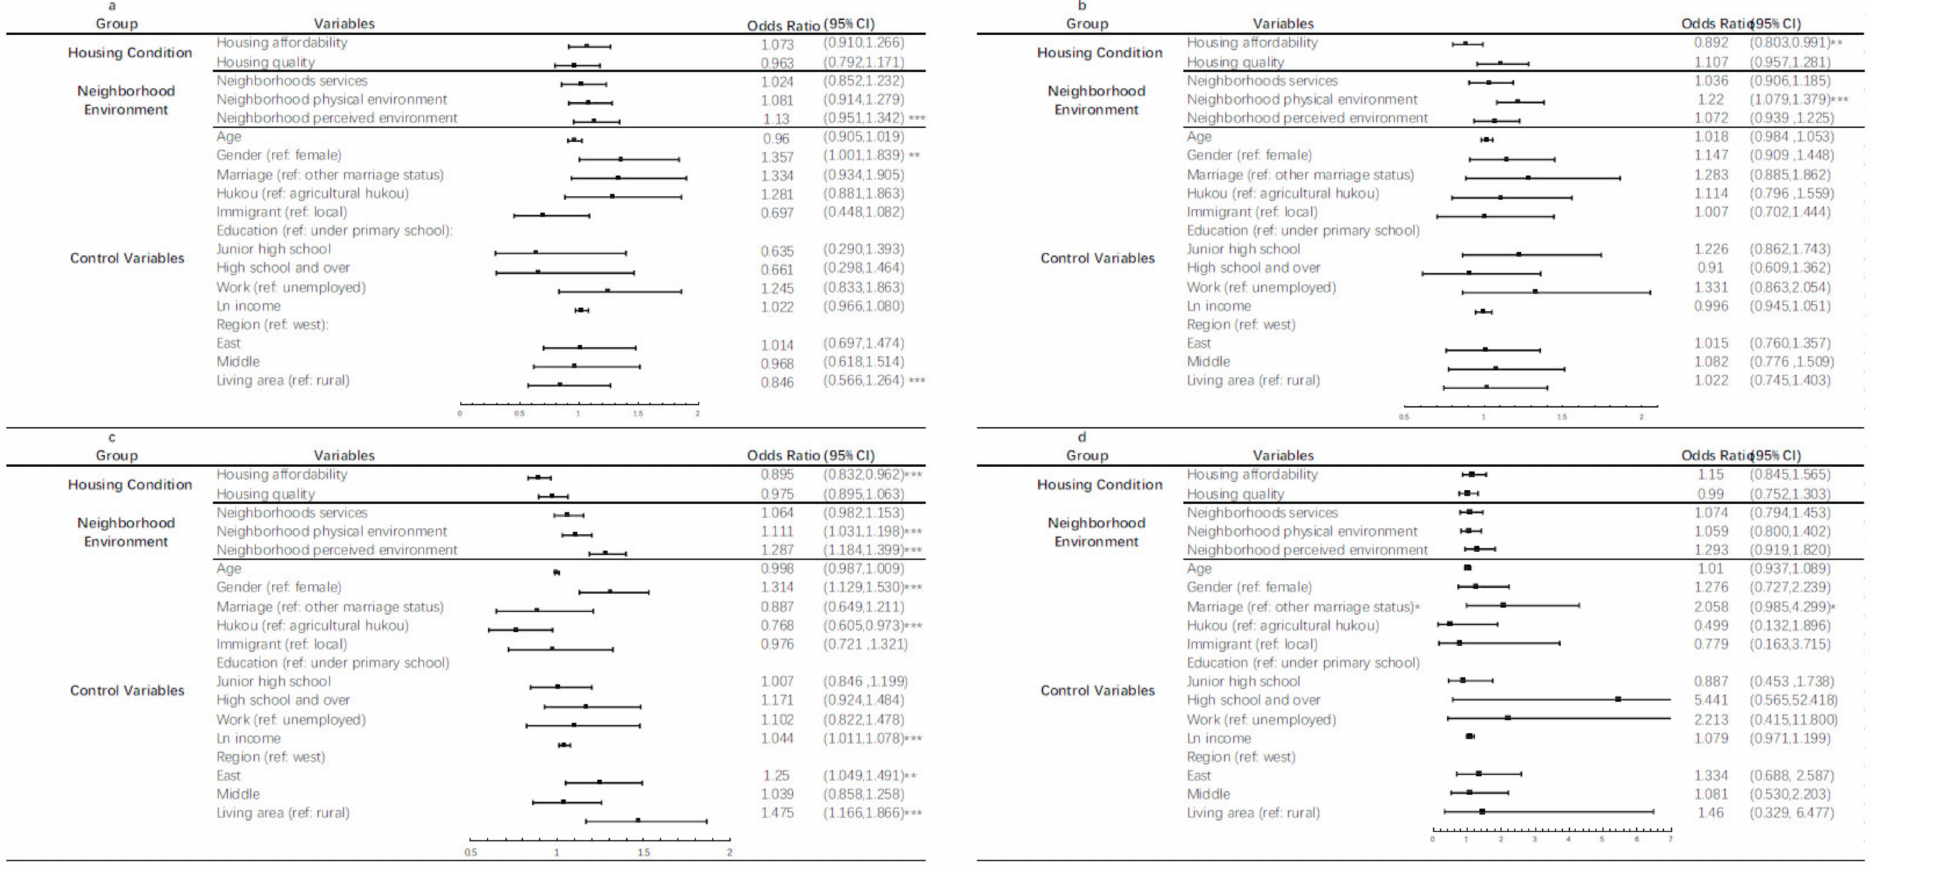
Figure 2. Results of the impact of built environment on mental health among different age groups: ( a ) age under 28, ( b ) age between 29 and 40, ( c ) age between 41 and 65 and ( d ) age over 66. Note: (1) 95% confidence interval in parentheses; (2) * p < 0.1; ** p < 0.05; *** p <